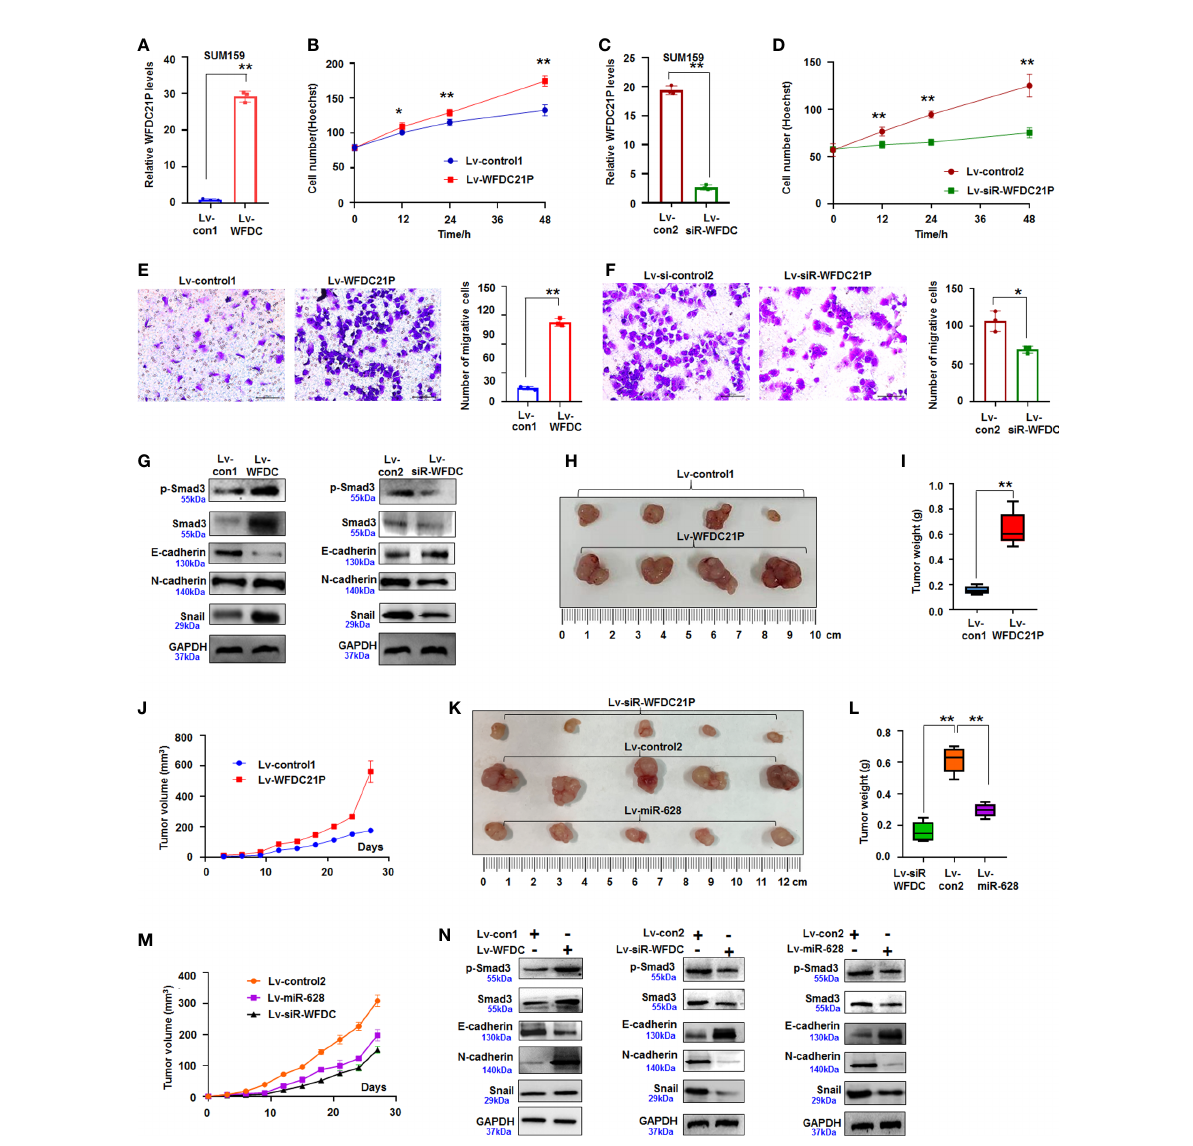
FIGURE 2 WFDC21P promoted SUM159 cell proliferation and metastasis. (A) qRT-PCR analysis of WFDC21P expression in lv-WFDC21P-overexpressed cells. Data are expressed as the mean ± SD of triplicate experiments. ** p < 0.01; Student ’ s t-test. (B) Hoechst staining assay illustrated that WFDC21P promoted SUM159 cell proliferation. Data are expressed as the mean ± SD of triplicate experiments. * p < 0.05, ** p < 0.01; ANOVA. (C) qRT-PCR analysis of WFDC21P expression in the lv-siR-WFDC21P-treated cells. Data are expressed as the mean ± SD of triplicate experiments. ** p < 0.01; Student ’ s t-test. (D) Hoechst staining assay. siRNA-WFDC21P decreased SUM159 cell proliferation. Data were expressed as mean ± SD for triplicate experiments. ** p < 0.01; ANOVA. (E, F) Metastasis of SUM159 cells infected with lv-WFDC21P or lv-siR-WFDC21P or with controls. Data are presented as the mean ± SD of triplicate experiments. * p < 0.05, ** p < 0.01; Student ’ s t-test. (G) immunoblotting detection of cell metastasis-related proteins. (H – J) Tumor size, weight, and volume changes were measured after nude mice were subcutaneously injected with SUM159 cells stably expressed with WFDC21P or control. Data are presented as the mean ± SD or median (interquartile range). n=4, ** p < 0.01; Student ’ s t-test or Mann – Whitney U test. (K – M) Tumor size, weight, and volume changes were measured after nude mice were subcutaneously injected with cells stably expressed with siRNA-WFDC21P, or miR-628, or control. Data are presented as the mean ± SD or median (interquartile range). n=4 ** p < 0.01; ANOVA or Kruskal-Wallis H test. (N) immunoblotting detection of cell metastasis-related proteins in